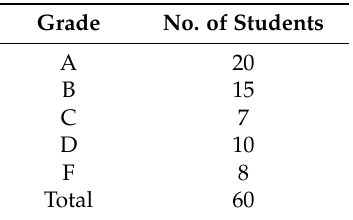
Table 4. Student